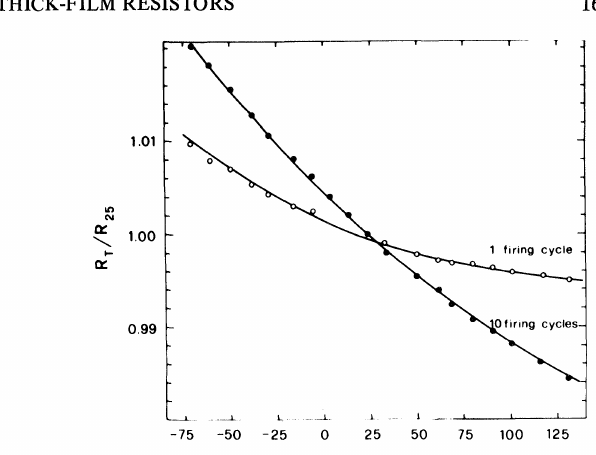
Temperature-dependence of resistance in SRD Plessey resistors 10 kohm/rn after and 10 firing